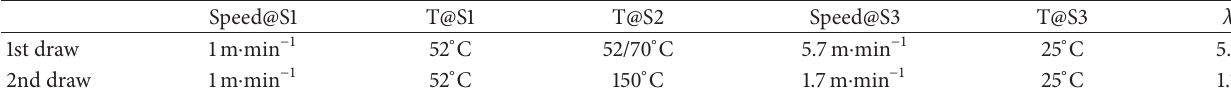
Table 2: Equipment settings for two-stage SSD process.